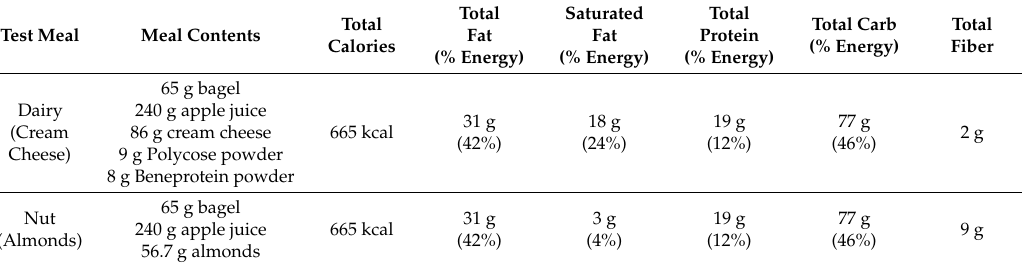
Table 1. Test Meal Macronutrient